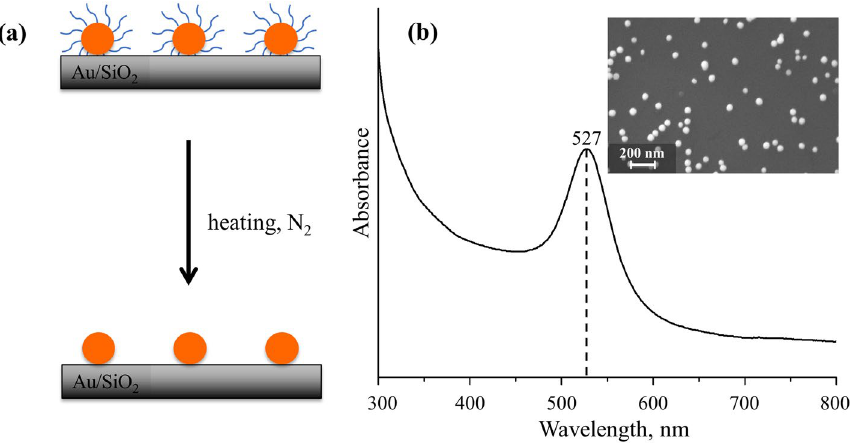
Figure 1. ( a ) Schematic of ligands removal of 50 nm Au NPs supported on SiO 2 using mild thermal treatment. ( b ) UV–Vis absorption spectrum of colloidal 50 nm Au NPs. The inset in ( b ) is a SEM micrograph of monodisperse Au NPs on SiO 2